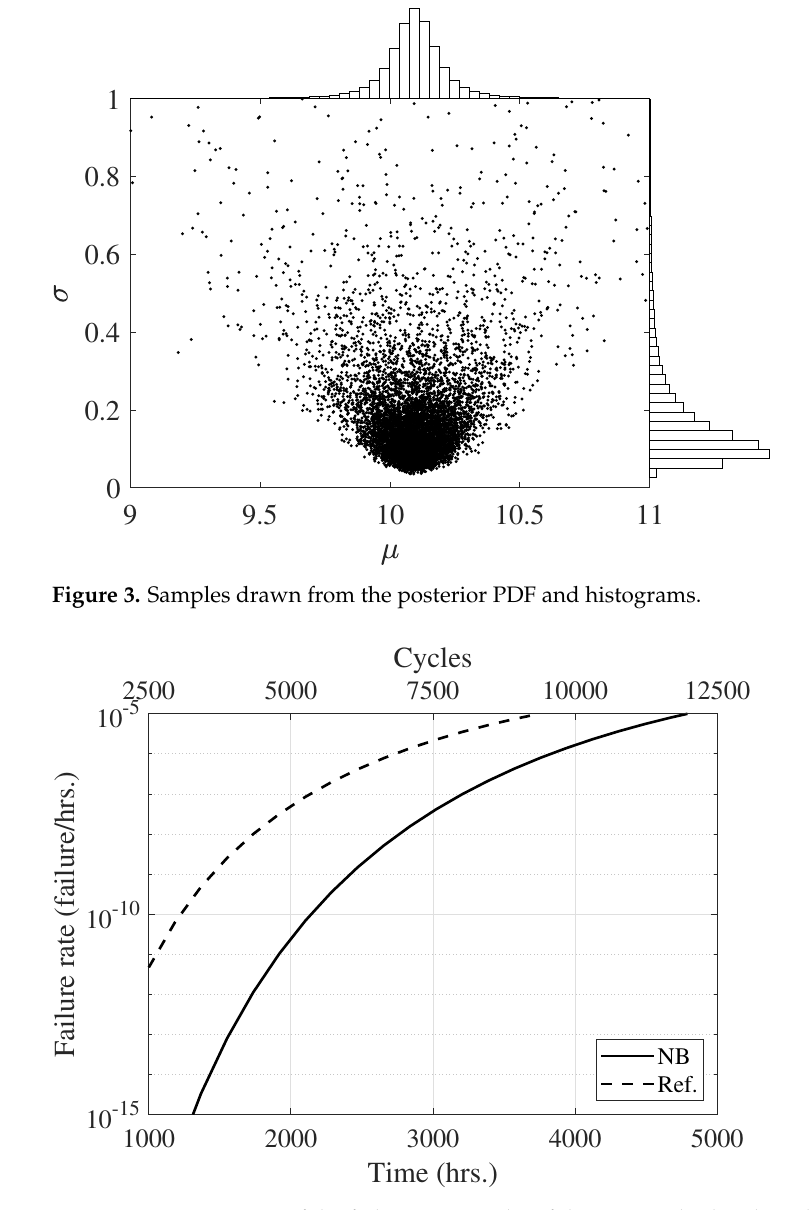
Figure 4. Comparisons of the failure rate results of the two methods. The solid line and the dashed line are results from the noninformative Bayesian (NB) and existing method (Ref.),